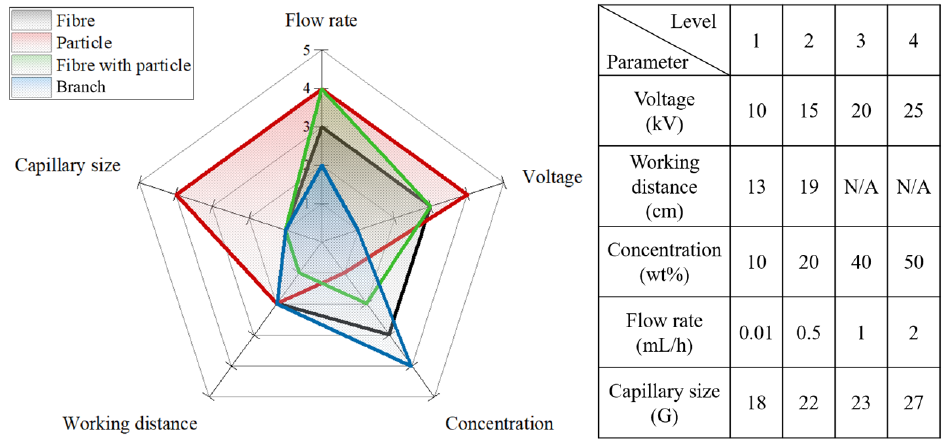
Figure 2. Optimisation of the parameters employed during preparation of the IMQ-PCL nanofibrous meshes and their effect on the morphology of the resulting IMQ-PCL nanofibrous mesh.